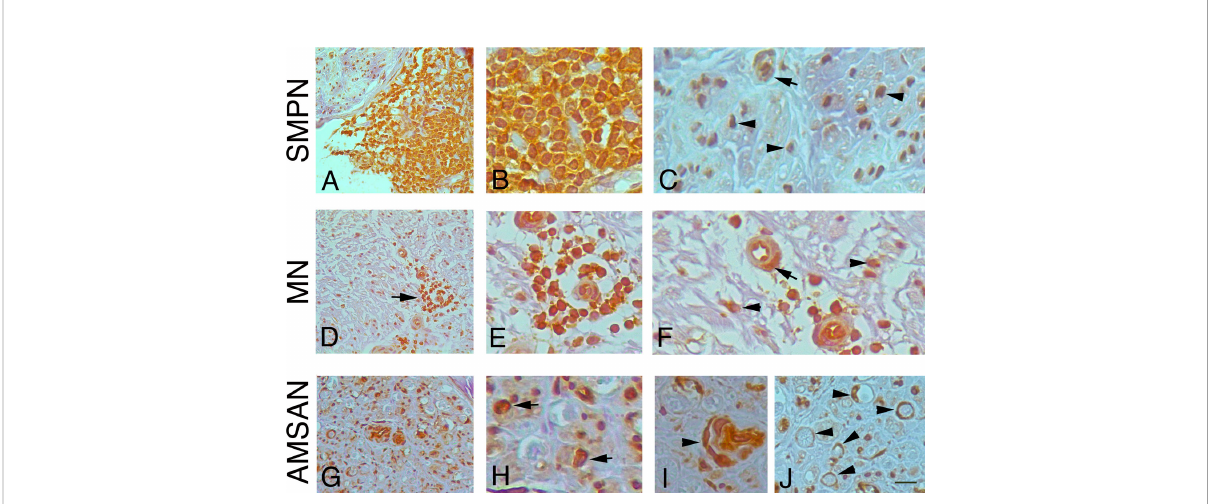
FIGURE 4 RPL26 expression in NL sural nerves. RPL26 immunoreactivity shows increase expression in NL sural nerves. RPL26 shows strong immunoreactivity of the malignant B-cells in the epineurium in SMPN (A, B) , endoneurial neuclei (C) , arrowheads and vessel (C) , arrow. In MN, strong immunoreactivity of perivascular malignant B-cells in the endoneurium ( D , E , arrow) was present; endothelial cells, pericytes ( F , arrow) and endoneurial cells were also positive ( F , arrowheads). In AMSAN, strong immunoreactivity was present in endoneurium ( G , H , arrows) in numerous cells, including endothelial cells and pericytes (arrowhead, i); RPL26 was associated with the rim of myelin sheets of Schwann cells ( J , arrowheads). Scale bar represent 20µm (A, D, G) ; 10 m m (B, C, E, F, H-J)